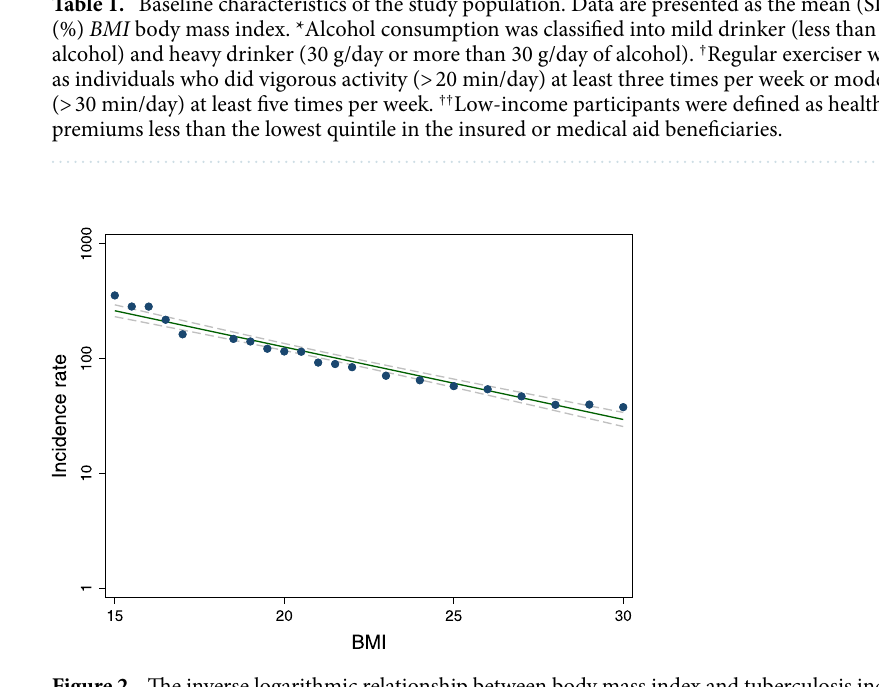
Across the BMI category in the underweight subpopulation, a significant inverse correlation between BMI and TB risk was observed ( p for trend < 0.001). The estimated adjusted HR for incident TB in the underweight popula- tion relative to normal weight population increased as the degree of thinness increased (adjusted HR = 1·98, 95% CI 1.91–2.05 for mild thinness; adjusted HR = 2.50, 95% CI 2.33–2.68 for moderate thinness; adjusted HR = 2.83, 95% CI 2.55–3.15 for severe thinness; p for trend < 0.001). The negative association between BMI category and incident TB among the underweight population was consistent in all subgroup analyses (Fig. 3).